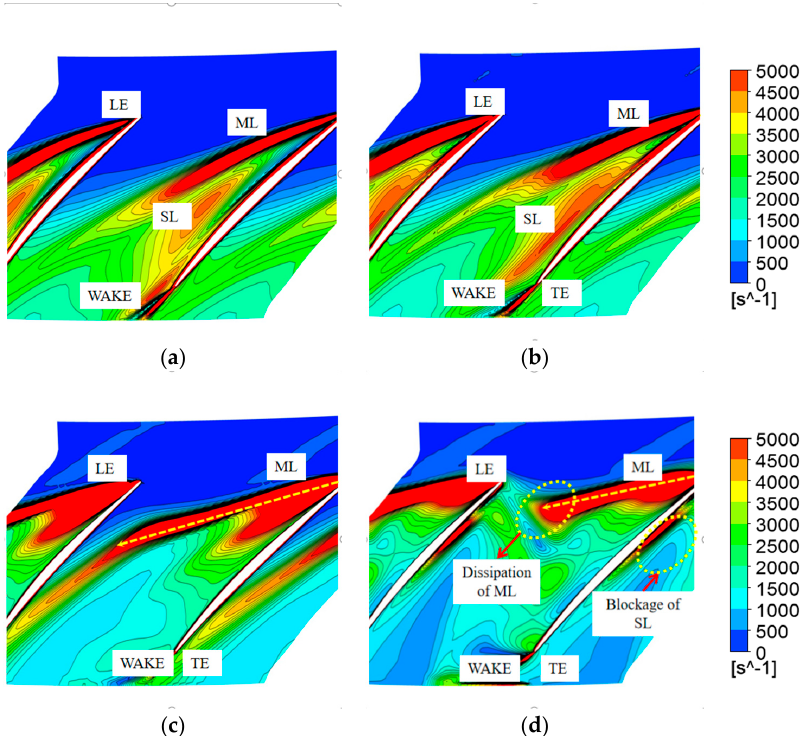
Figure 6. Vorticity contour at 0.98 H of rotor with different flow coefficient. ( a ) 0.5; ( b ) 0.46; ( c ) 0.42; ( d )